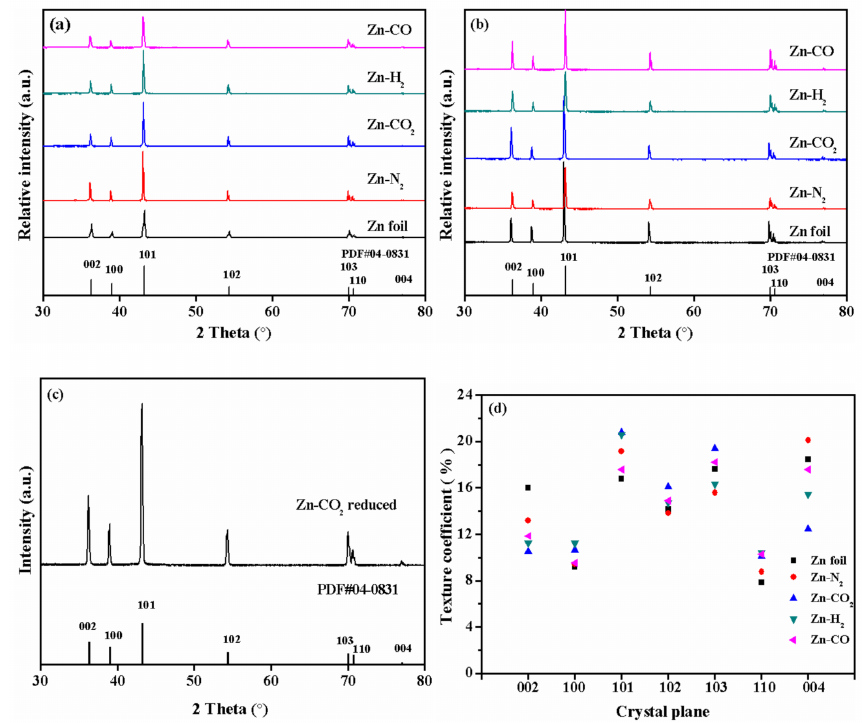
Figure 2. X-ray diffraction (XRD) patterns of prepared Zn electrodes: ( a ) before reaction, ( b ) after reaction and ( c ) the reduced Zn-CO 2 electrode; ( d ) texture coefficients of Zn electrodes before